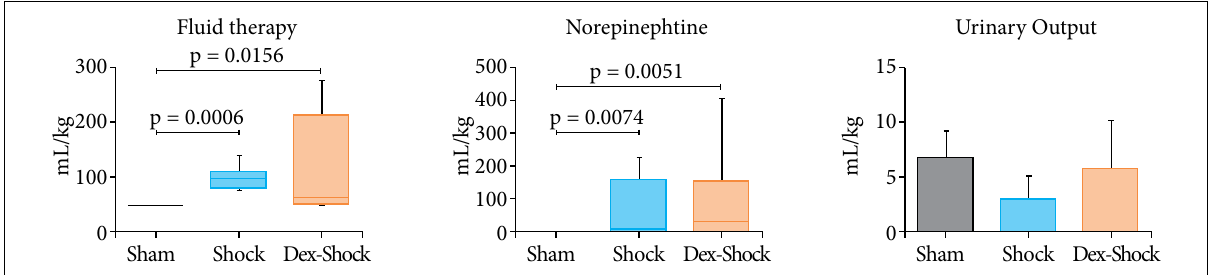
Figure 2 - Fluid loading, total dose of norepinephrine, and urinary output in anaesthetised pigs (Sham group), septic shock animals (Shock group), and septic shock animals receiving dexmedetomidine (Dex-Shock